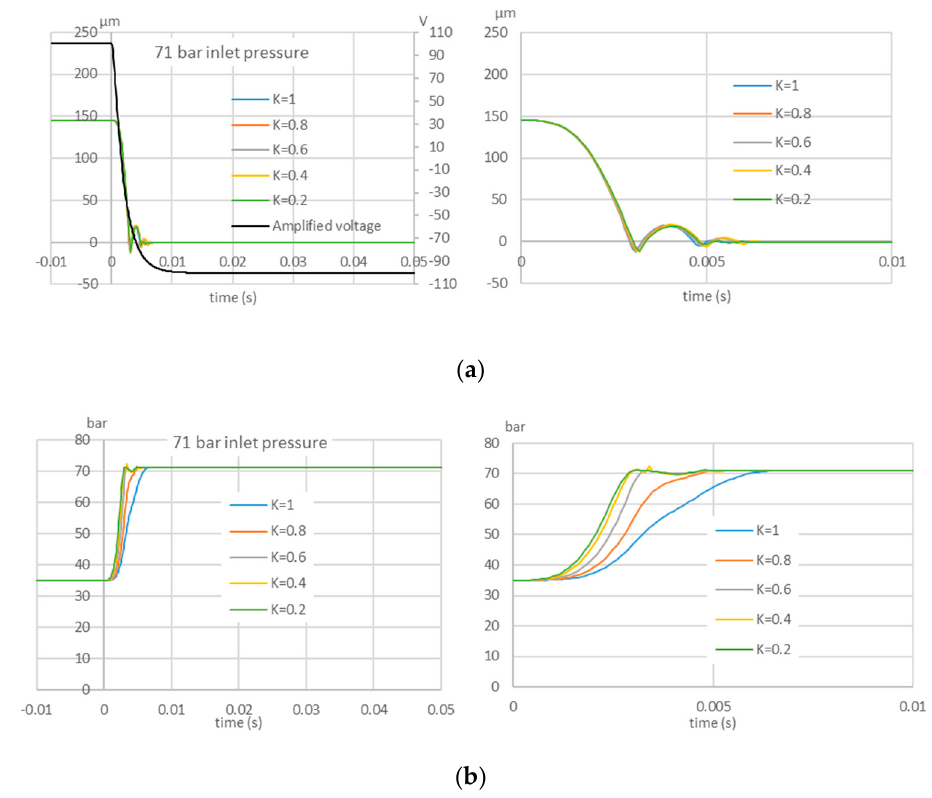
Figure 12. Ring bender displacement with enlargement ( a ) and pressure at point 7 with enlargement ( b ), simulated for an amplified voltage from +100 V to − 100 V and for different volumes of the chamber comprised between the restriction (6) and the nozzle (10), having diameter D = K D 0 and length L = K L 0 , with K = 1, 0.8, 0.6, 0.4, 0.2 (supply pressure = 71 bar).